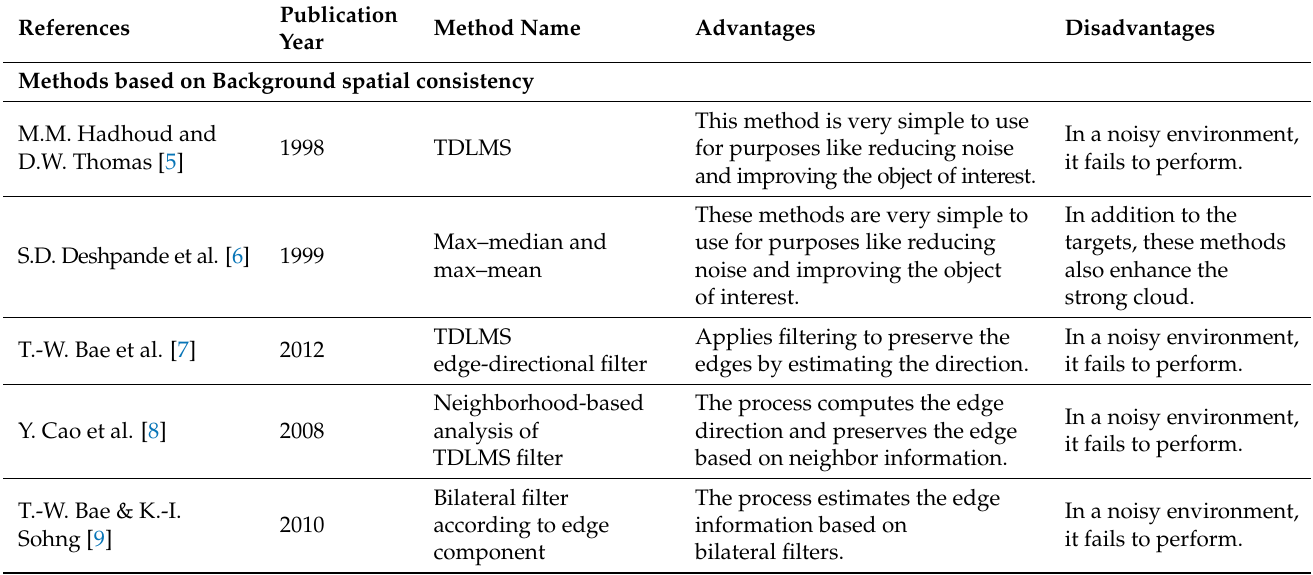
Table 1. Details of the key state-of-the-art target detection